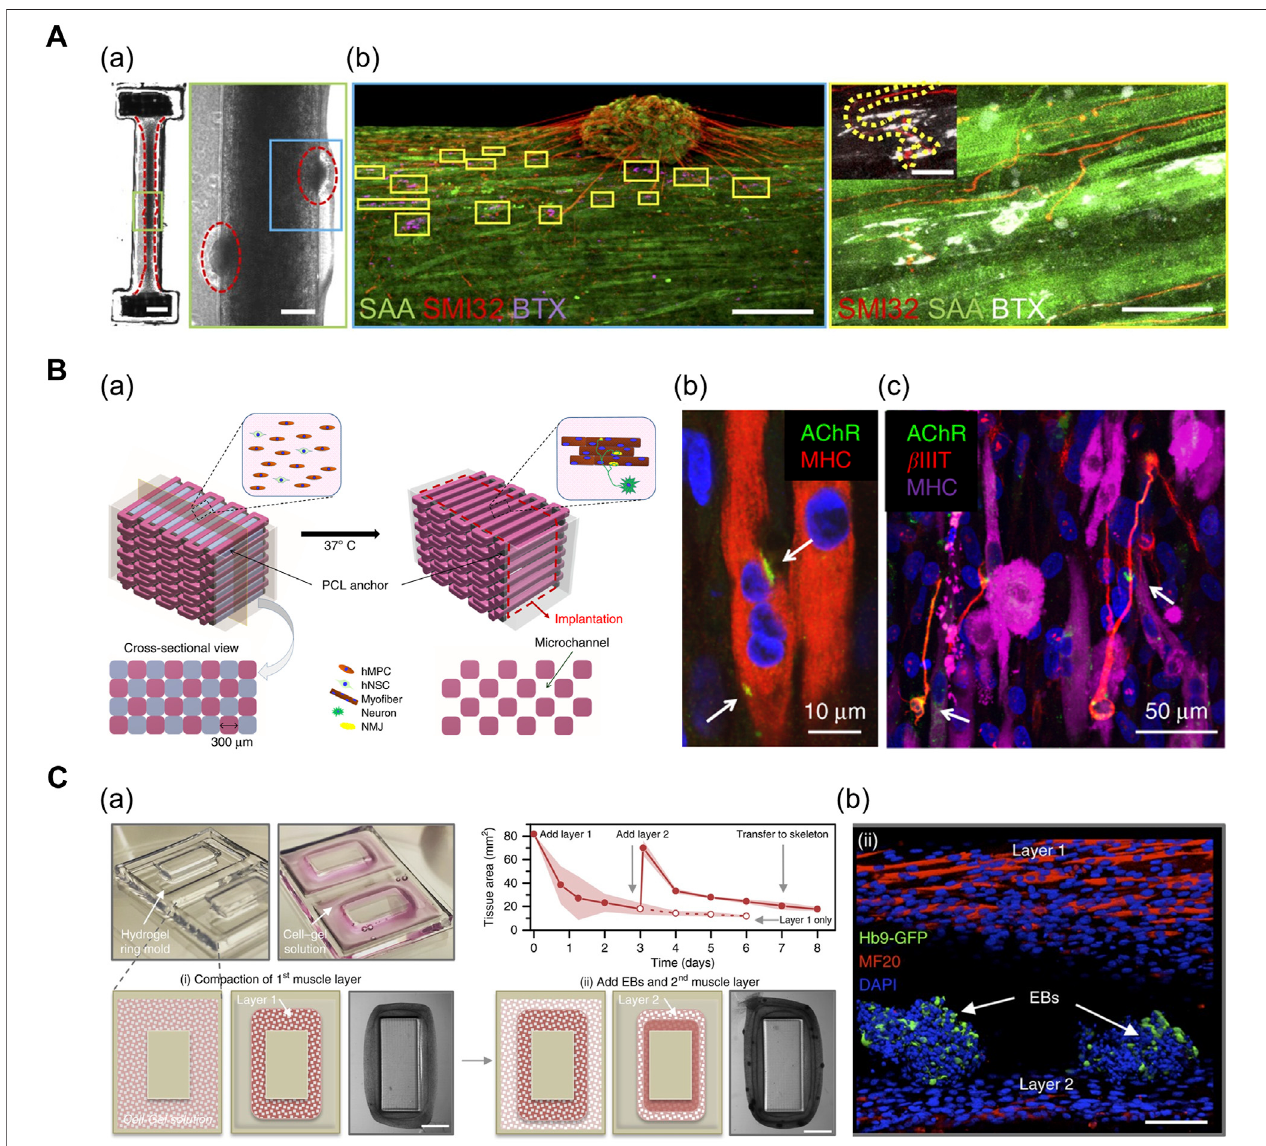
sarcomeric α -actinin, SMI32:anti-200kDneuro fi lamentheavyantibody,BTX: α -bungarotoxin.Reprintedwithpermissionfrom(Bakooshlietal.,2019). (B) 3Dbioprinted innervated muscle construct. (a) 3D CAD modeling of bioprinted construct. Hollow microchannels formed after removing sacri fi cial patterns. (b) Confocal image of acetylcholine receptors (green) prepatterned on myo fi bers (red). (c) Confocal image of neurites (red) contacting acetylcholine receptor clusters (green). β IIIT: beta-III tubulin. Reprinted with permission from (Kim et al., 2020). (C) Modular muscle – motor neuron co-culture system. (a) Schematic of fabrication of multilayered tissue